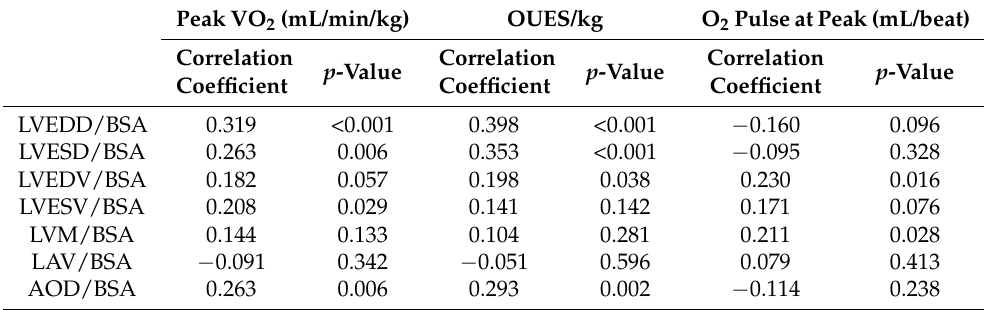
Table 4. Pearson’s correlation analysis between cardiopulmonary exercise testing and echocardio- graphic parameters. Peak VO 2 (mL/min/kg)